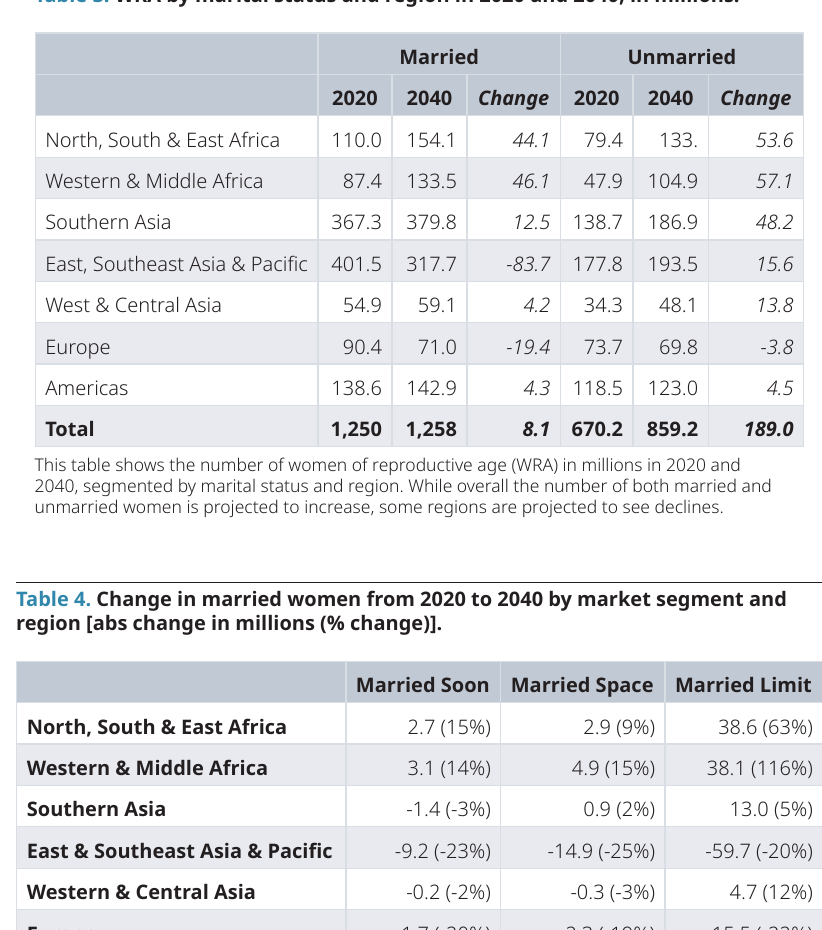
Table 3. WRA by marital status and region in 2020 and 2040, in millions.